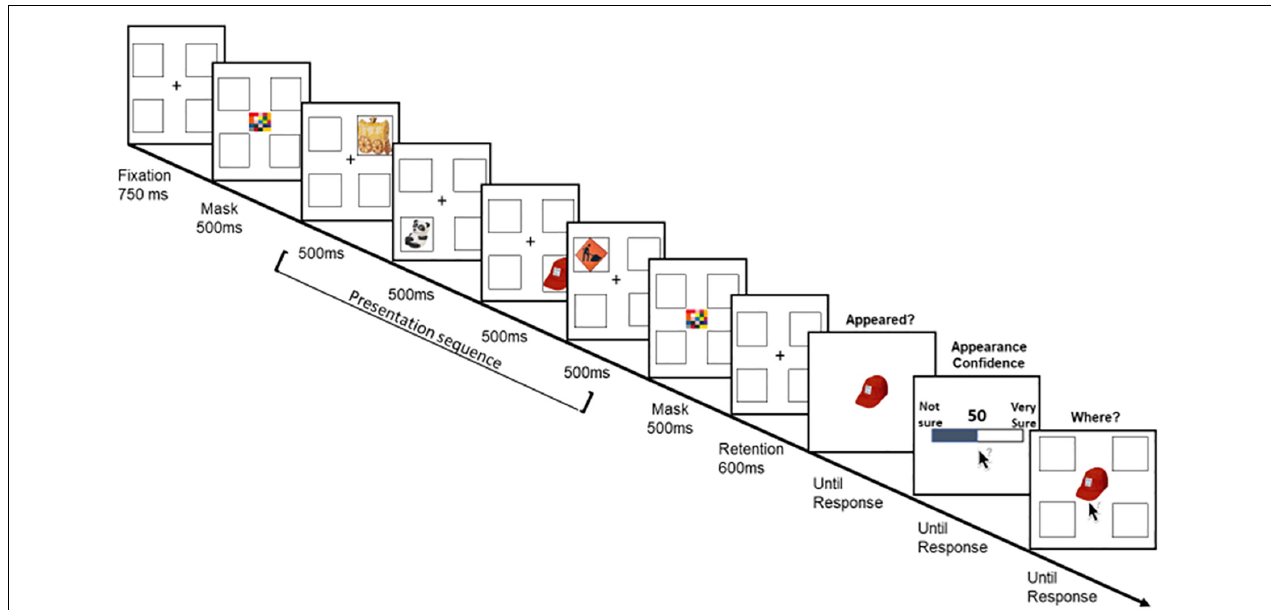
FIGURE 2 | A schematic illustration of Experiment’s 2 trial’s